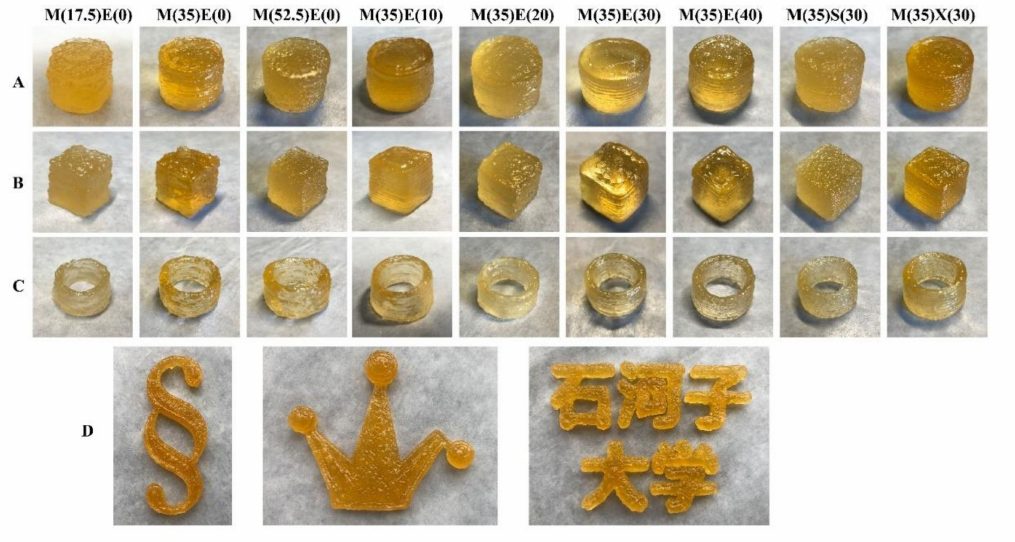
Figure 1. Printing performance with different formulation inks. ( A ) Solid cylinders with diameter of 15 mm and height of 15 mm. ( B ) Cubes with side length of 10 mm. ( C ) Hollow cylinders with wall thickness of 2 mm and height of 15 mm. ( D ) Gummies of different shapes printed with gummy